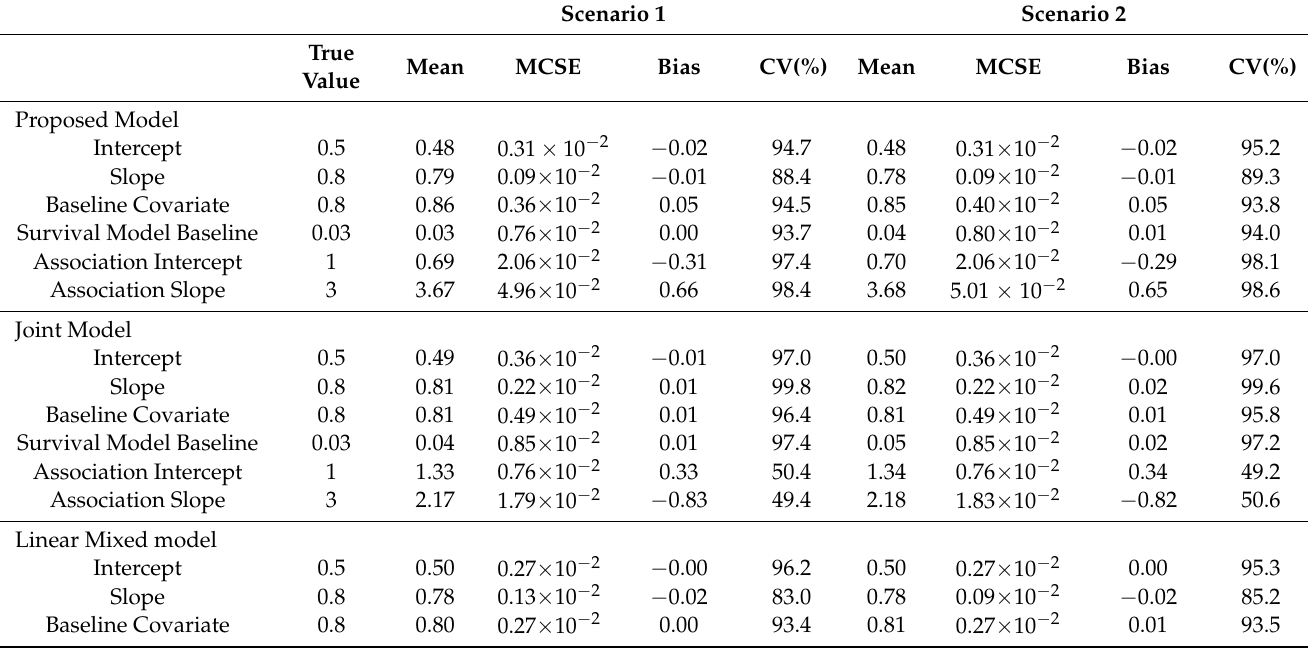
Table 1. Performance of the different models under scenario 1 and scenario 2: results from 1000 replications with each dataset containing 300